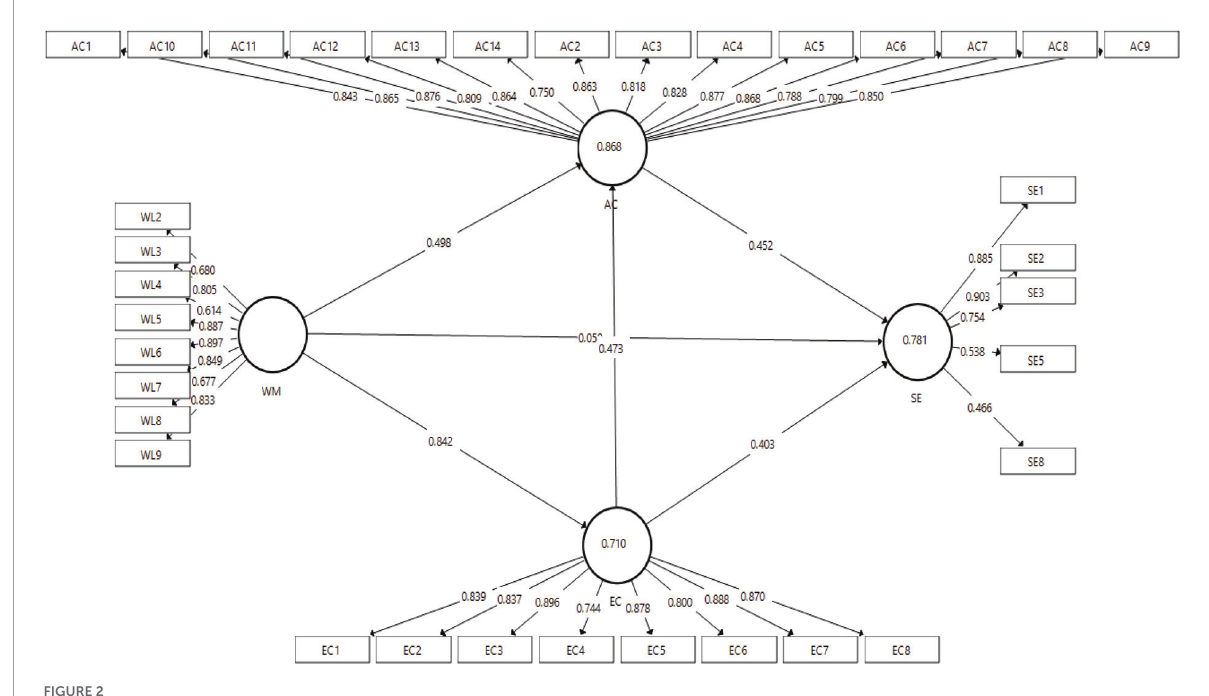
FIGURE2 Structural model